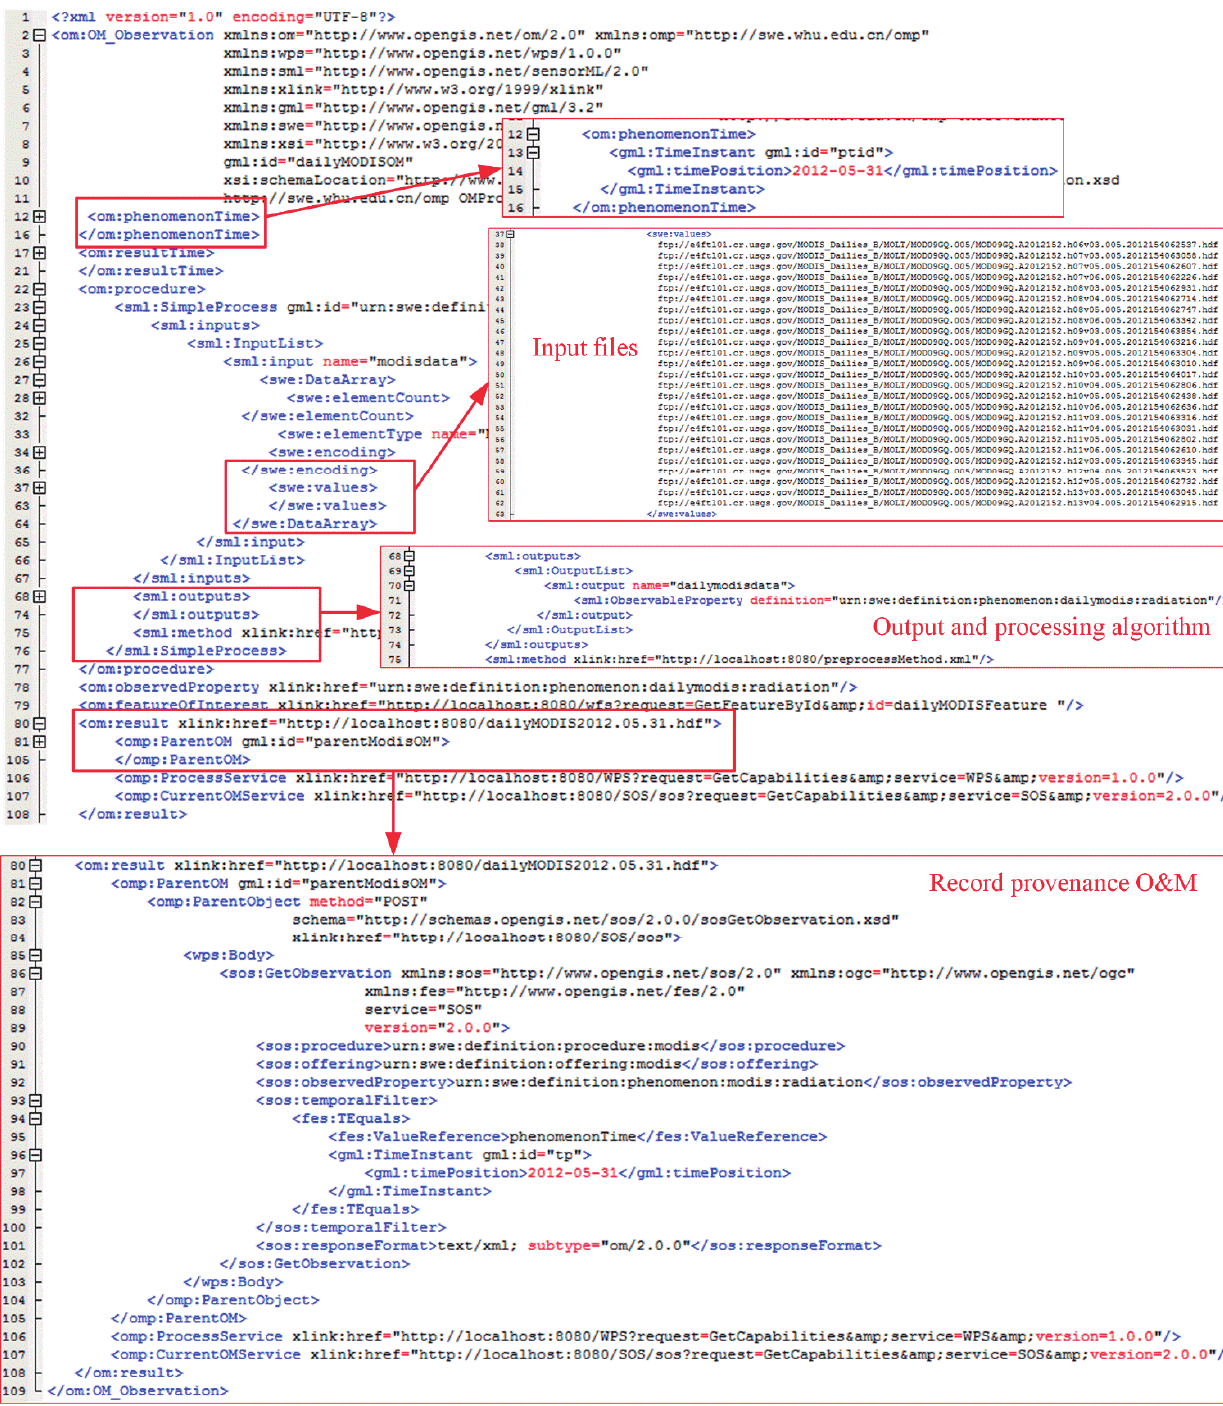
Figure 10. Daily MODIS